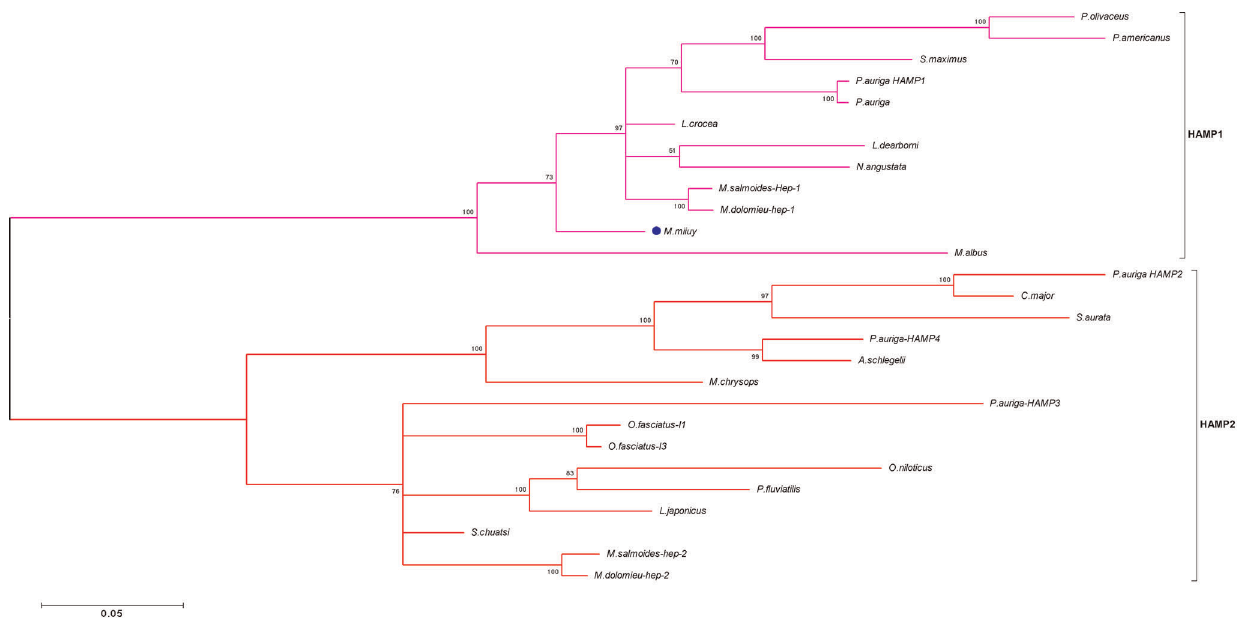
Figure 2. Phylogenetic tree of hepcidin gene from miiuy croaker and other teleost were constructed using Bayesian inference method.